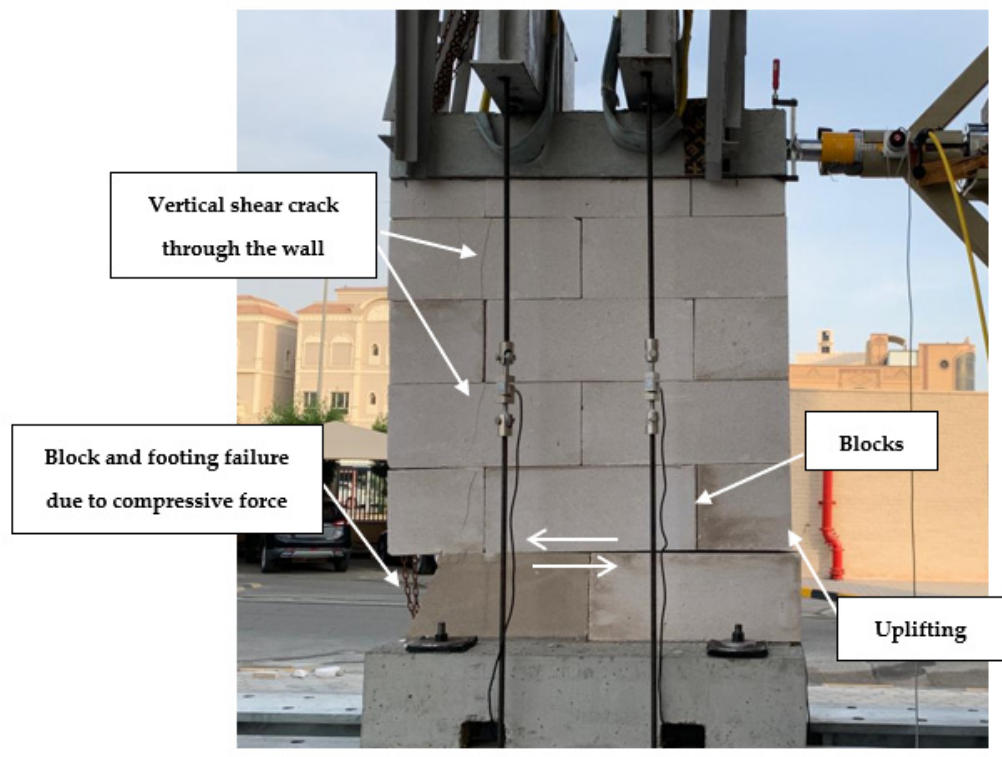
Figure 14. Overall failure of the unreinforced wall after testing and before force release.